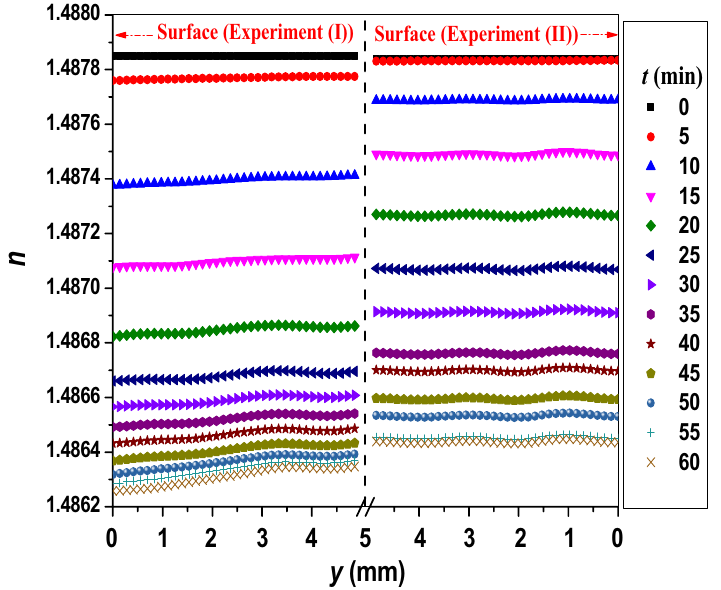
Figure 7. Spatial refractive index profiles of UV 254 irradiated toluene at discrete times of irradiation in the two experiments.